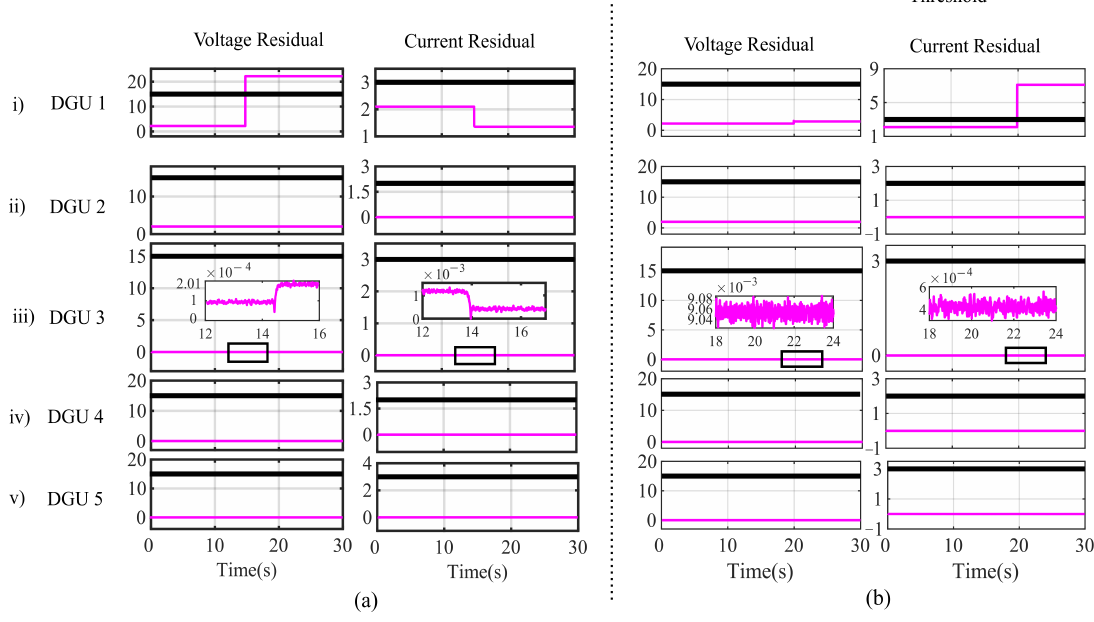
Figure 5. Performance of the observer during sensor faults in DGU 1. ( a ) Voltage and current residuals of the DGUs during voltage sensor fault; ( b ) Voltage and current residuals of the DGUs during current sensor